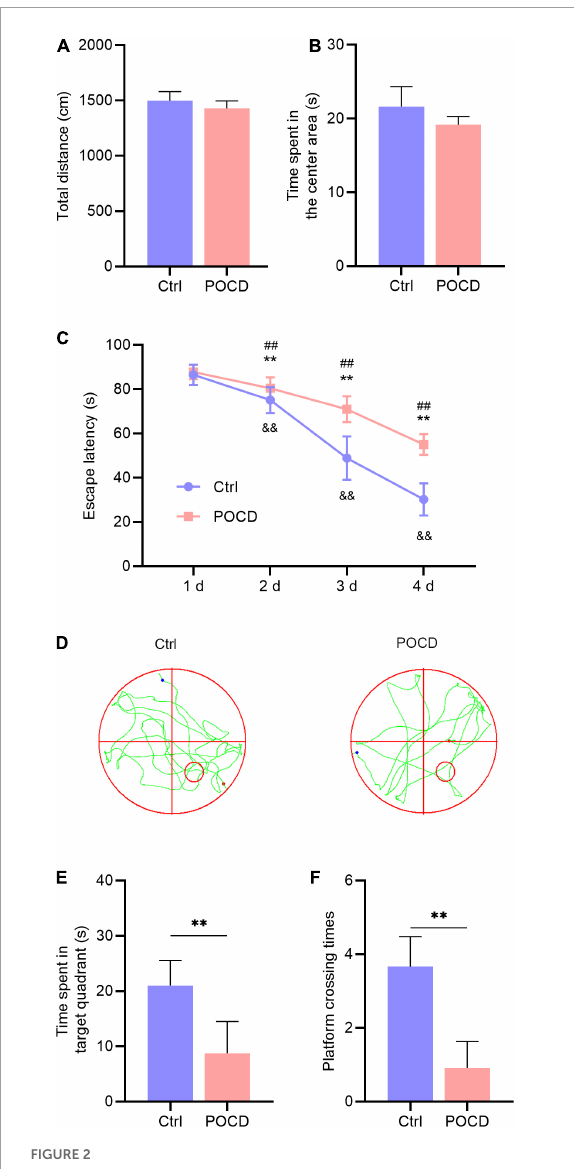
FIGURE2 Anesthesia/surgery impaired cognitive function in aged mice ( n = 6 per group). (A) The total distance in the OFT. (B) Time spent in the center area in the OFT. (C) Escape latency to reach the hidden platform during the 4-day training. Unpaired t -test, ** p < 0.01 compared to the control group; ## p < 0.01 compared to the first day in the control group; && p < 0.01 compared to the first day in the POCD group. (D) The swimming trajectory of the control and POCD mice during the probe test. The red circle indicates the hidden platform, the red and blue dot indicate the start and end of swimming, respectively. (E) Time spent in the target quadrant during the probe test. Unpaired t -test, ** p < 0.01 compared to the control group. (F) Platform crossing times during the probe test.